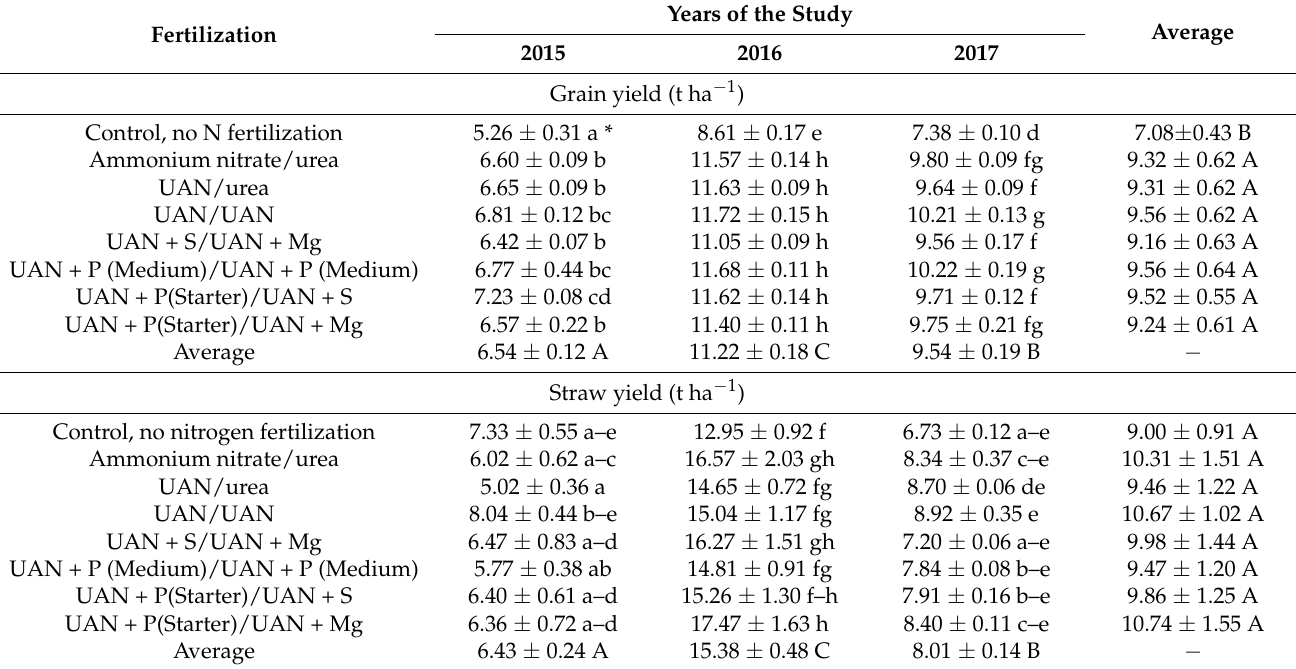
Table 3. Yields of common maize (mean ±